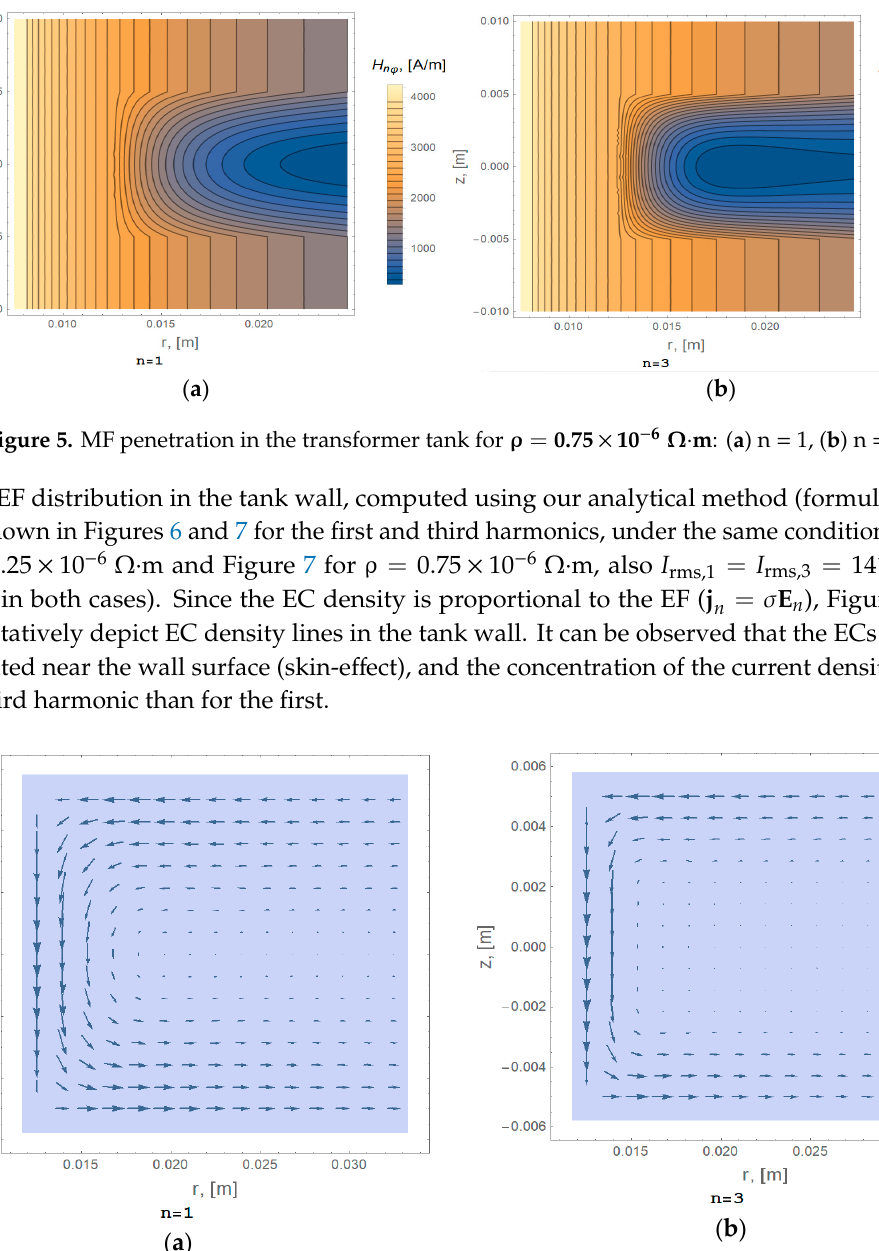
Figure 4. Magnetic field (MF) penetration in the transformer tank for (cid:2761) = (cid:2777).(cid:2779)(cid:2782) × (cid:2778)(cid:2777) (cid:2879)(cid:2783) (cid:2743) · (cid:1813) : ( a ) n = 1, ( b ) n = 3.